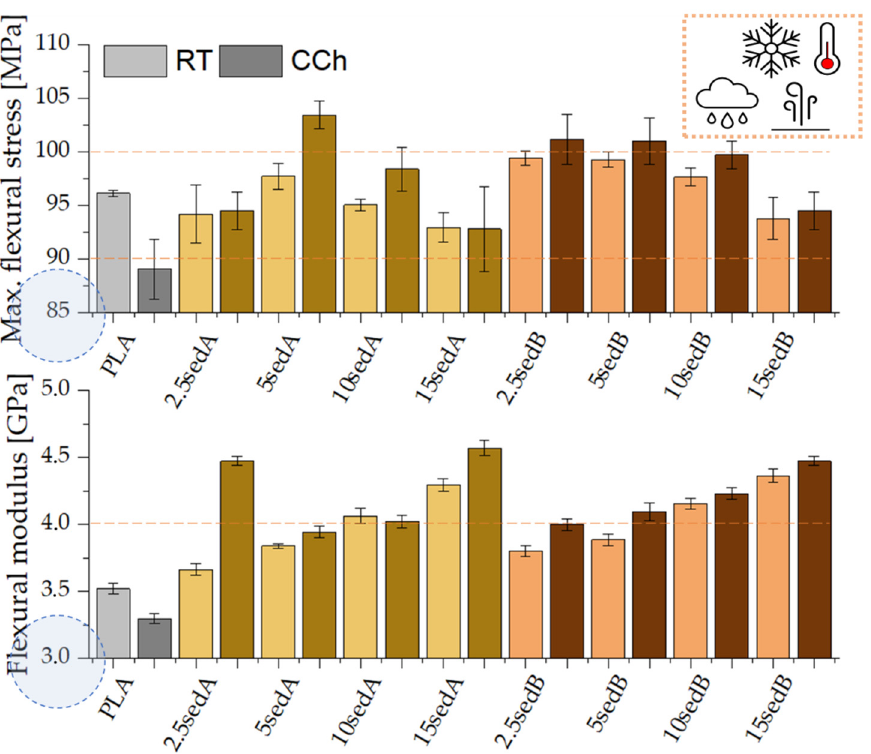
Figure 16. Flexural modulus and max. flexural stress for the composites PLA/sedA-B after conditioning in the weathering chamber (WCh).